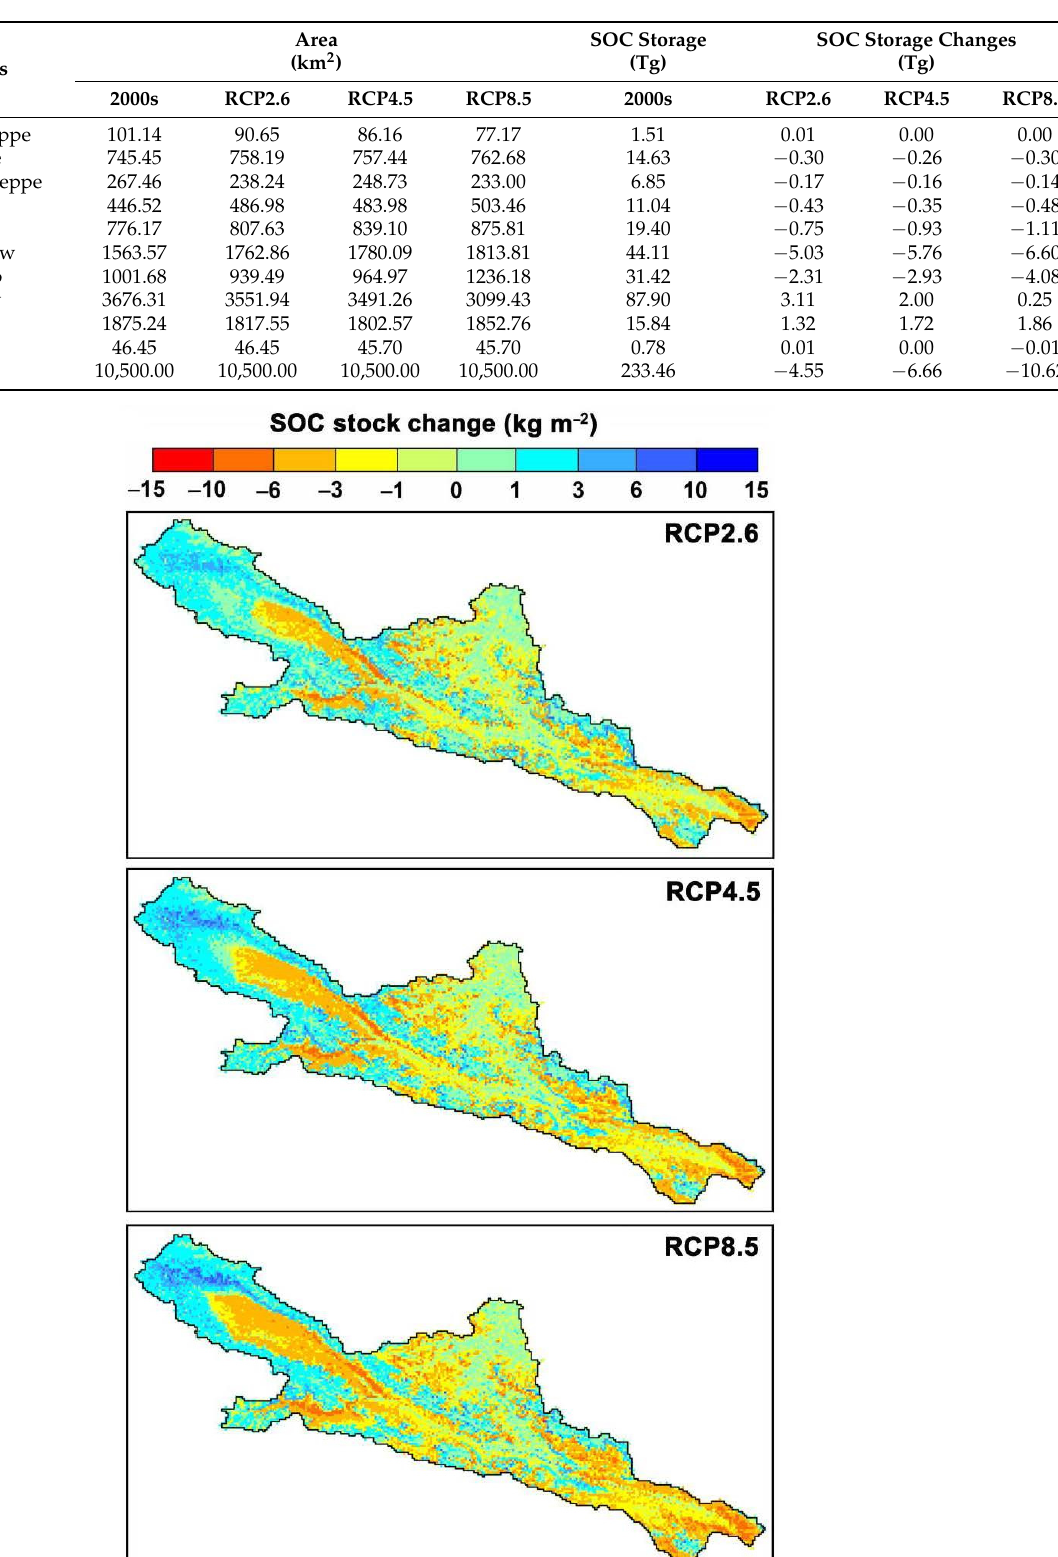
Table 4. Summary of SOC stocks and storage changes by vegetation types under different climate change scenarios from the 2000s to the 2050s.